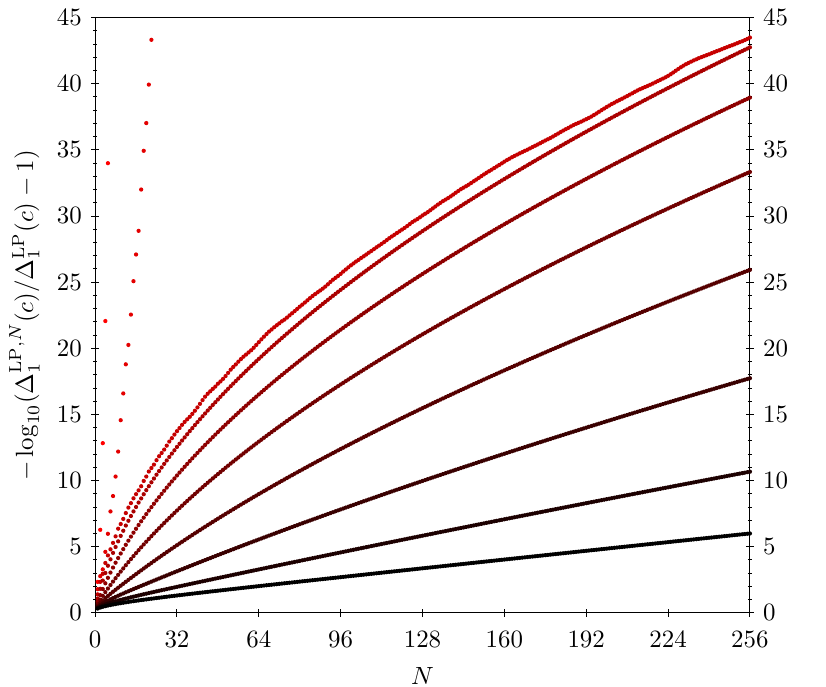
Figure 19 . Convergence of ∆ LP ,N through